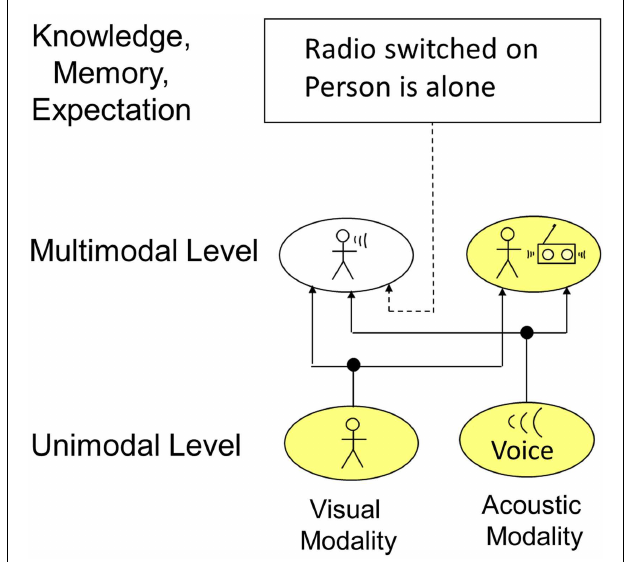
FIGURE 9 | Influence of knowledge, memory, and expectation on perception.